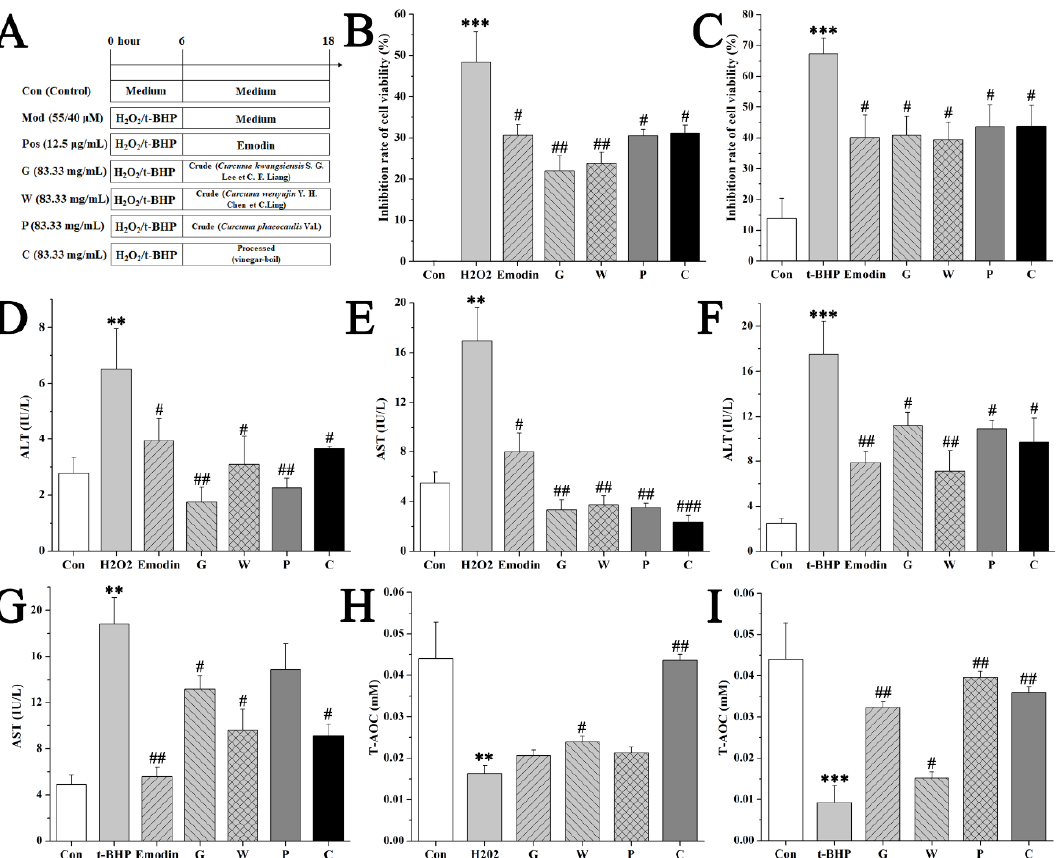
Figure 2. Efficacy evaluation of the crude and processed Curcuma zedoaria on oxidative liver injury by normal hepatic cell line (L02) assays. ( A ) The schematic diagram of the experimental design. Con, control group treated with phosphate buffered saline (PBS); Mod, model group treated with 55 μM H2O2 or 40 μM tertbutyl hydfroperoxide (t-BHP); Pos, positive control group treated with emodin (12.5 μg/mL); G, W, P, C, cells treated with Curcuma kwangsiensis S. G. Lee et C. F. Liang, Curcuma wenyujin Y. H. Chen et C.Ling, Curcuma phaeocaulis Val., and vinegar-processed Curcuma zedoaria at doses of 83.33 mg/mL, respectively. ( B – C ) Inhibition rate of cell viability of L02 for MTT assays. ( D – G ) The cellular alanine aminotransferase (ALT) and aspartate aminotransferase (AST) levels of H2O2 or t-BHP model, respectively. (H-I) The cellular total antioxidant capacity (T-AOC) levels of H2O2 or t-BHP models, respectively. ANOVA with the post hoc test was used to calculate the significance of the differences, ** and *** represents p < 0.01, and p < 0.001 compared with the control group; #, ## and ### represent p < 0.05, p < 0.01, and p < 0.001 compared with the model group, respectively. All experiments were performed three times, and the results are expressed as the mean ± S.D.